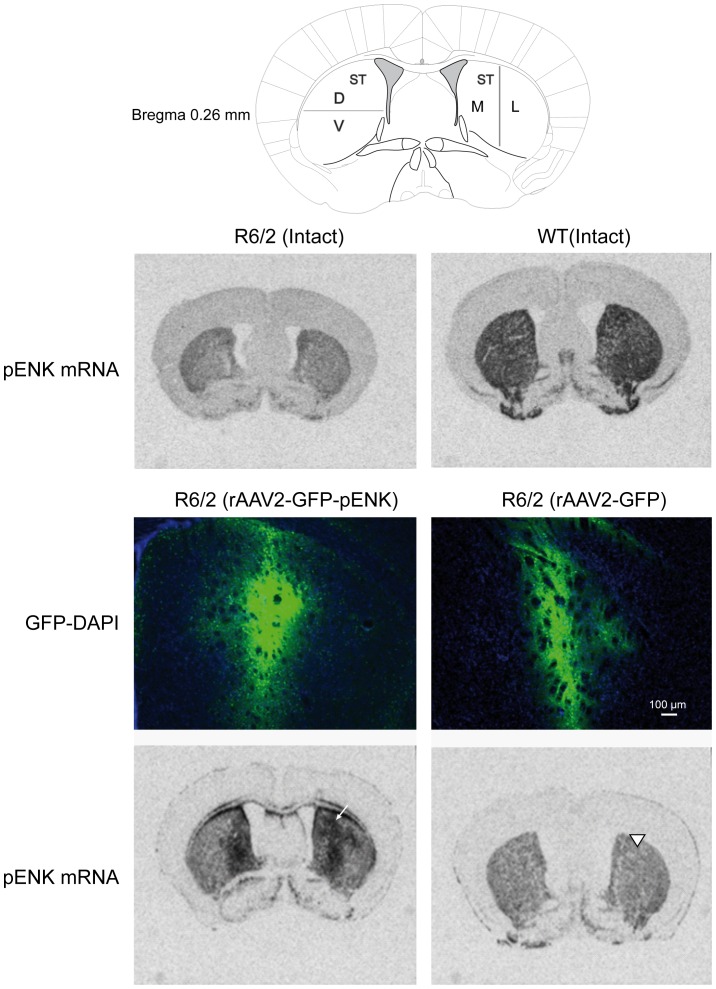
Representative images of the site of injection of rAAV2- in the striatum, revealed by GFP-DAPI double labeling, as well as representative autoradiograms of striatal pENK mRNA (in situ hybridization), compared to the schematic of the mouse brain (adapted from the atlas of Franklin and Paxinos, 2008).Arrow indicates the site of injection of rAAV2-GFP-pENK which corresponds to the overexpression of striatal pENK mRNA. Arrowhead indicates the site of injection of rAAV2-GFP without any changes in the expression of striatal pENK mRNA.